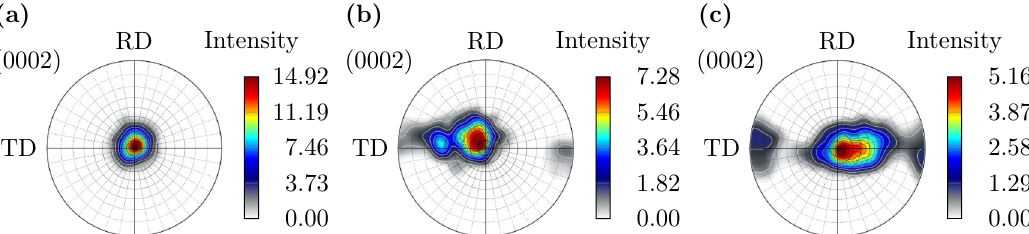
Figure 5. (0002) Pole figures: ( a ) from the as-received material; ( b ) the hot-bent material of the tension layer; ( c ) the hot-bent material of the compression layer. The data for the pole figure is obtained by an EBSD measurement with a scan size of 540µm 225µm (TD × ×